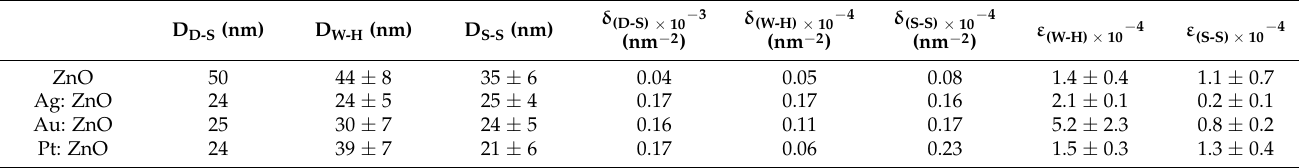
Table 3. Comparison of the obtained crystallite sizes (D) using the Debye–Scherer formula (D-S), Williamson-Hall (W-H), and size-strain (S-S) plots. Corresponding dislocation densities ( δ ) and strains ( ε ) are